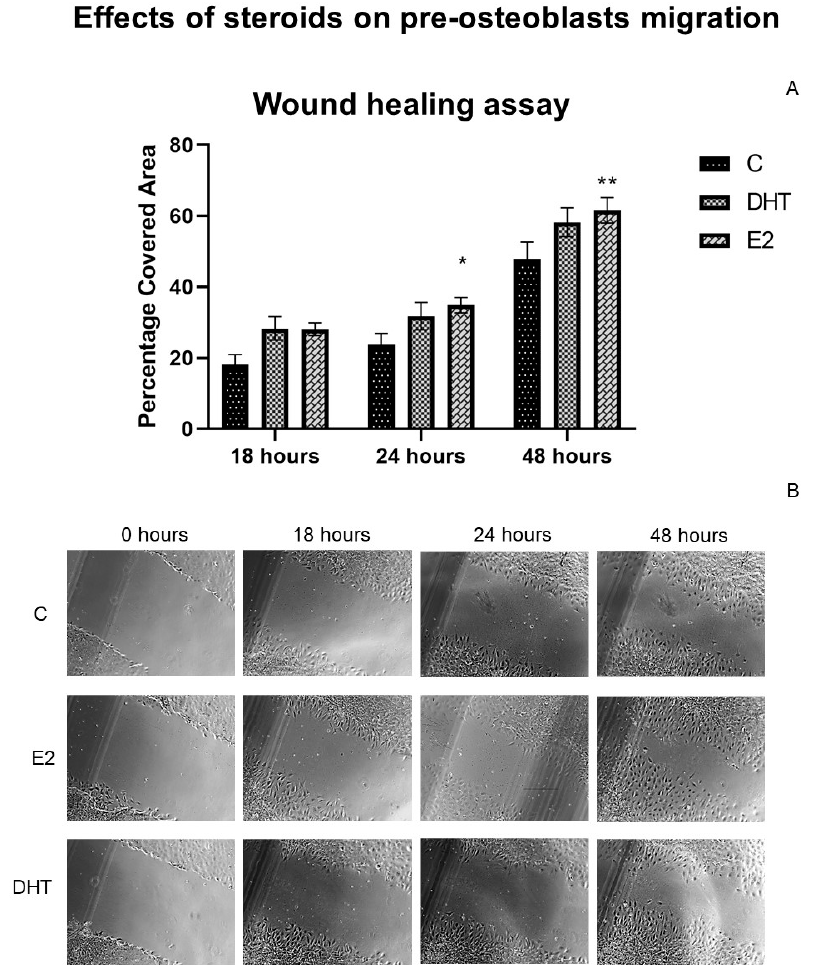
Figure 8. Effects of steroids’ milieu on pre-osteoblast migration. E2 promotes the migration of MC3T3-E1 cells in a wound-healing assay. Steroid treatment (10 − 9 M, DHT, and E2) was